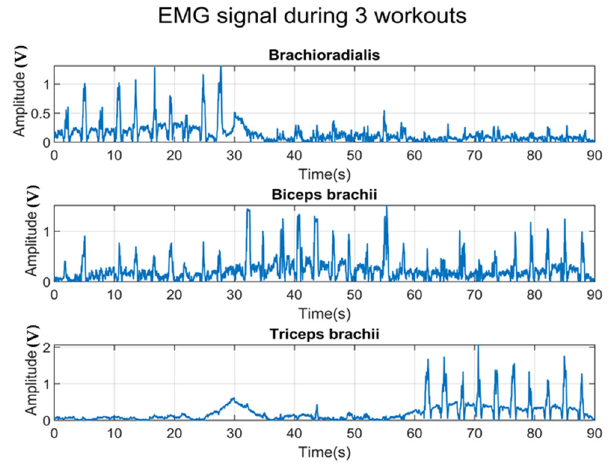
Figure 9. EMG data were collected from 3 muscles during 3 workouts. Each of them was carried out for 30 s (90 s in total) in the following order: Wrist Curl, Biceps Curl, and Dumbbell Kickback.